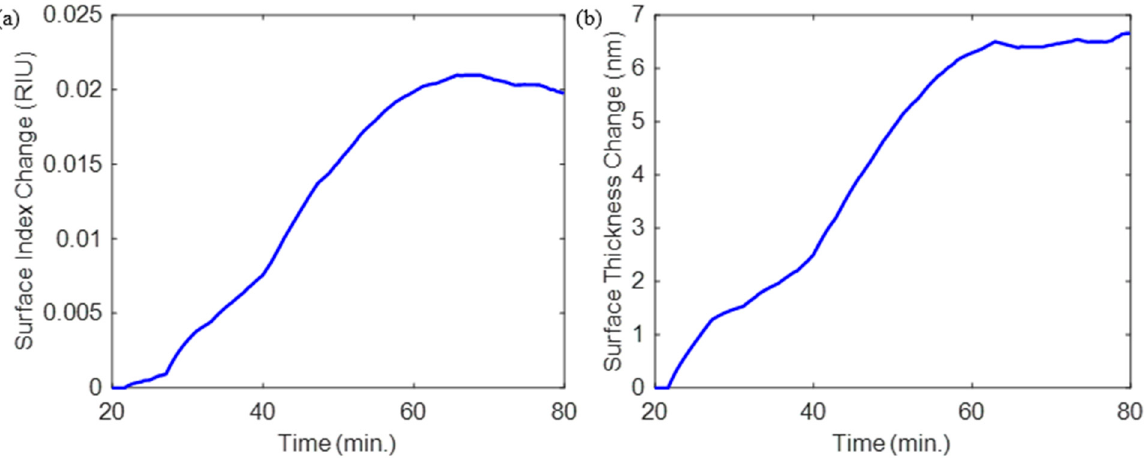
Figure 13. Changes in the ( a ) biolayer refractive index and ( b ) biolayer thickness during the incubation of the sensor in yeast. During this process, the change in the bulk refractive index ( Δ n bulk ) is calculated to be 0 RIU.